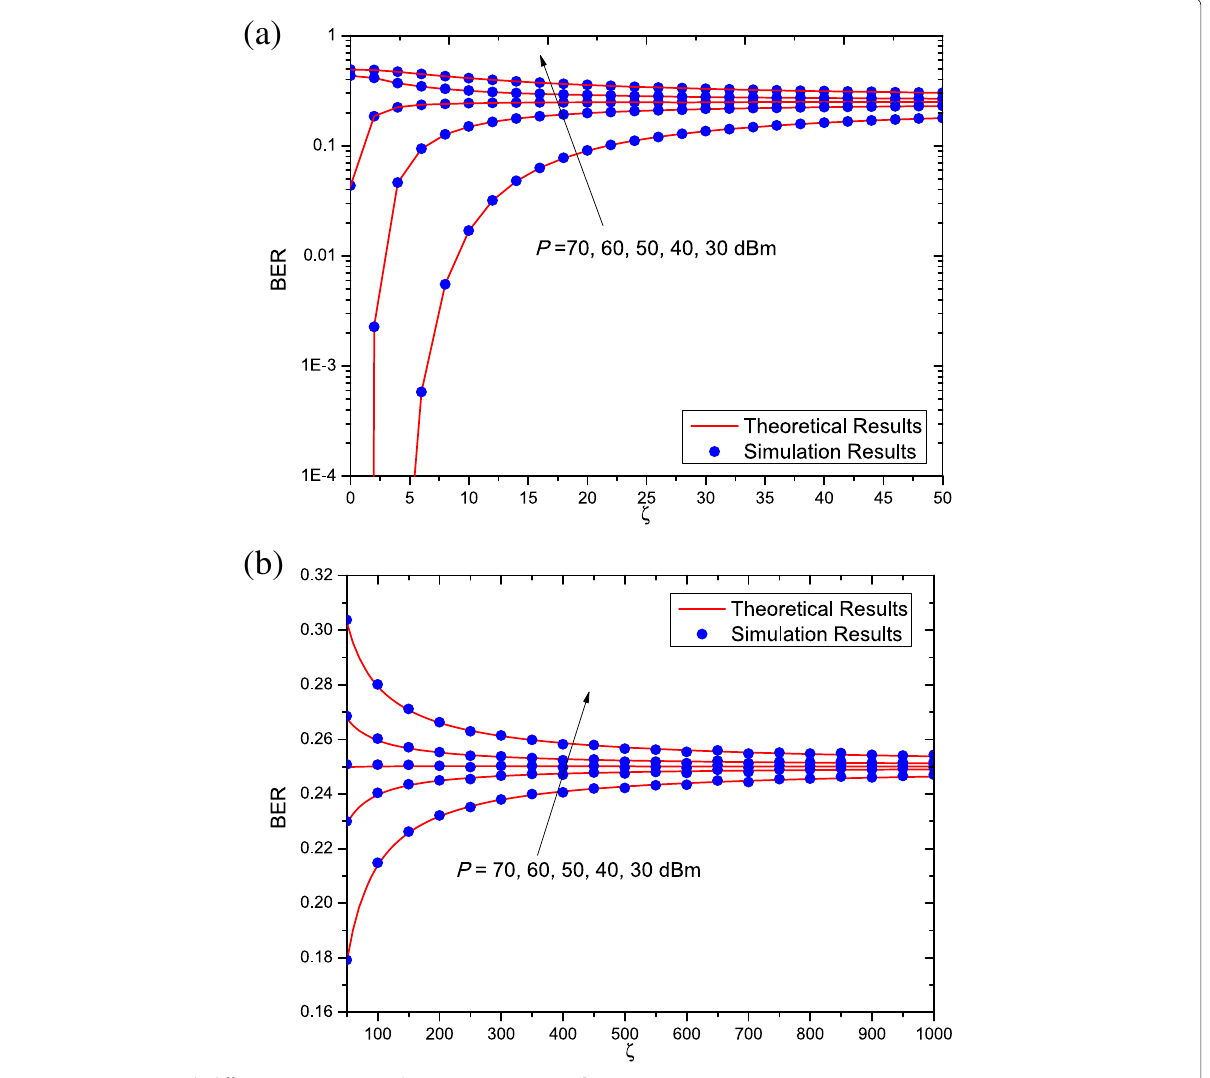
Fig. 5 BER versus ς with different transmit optical powers. a ς ∈ (0, 50), b ς ∈ (50,